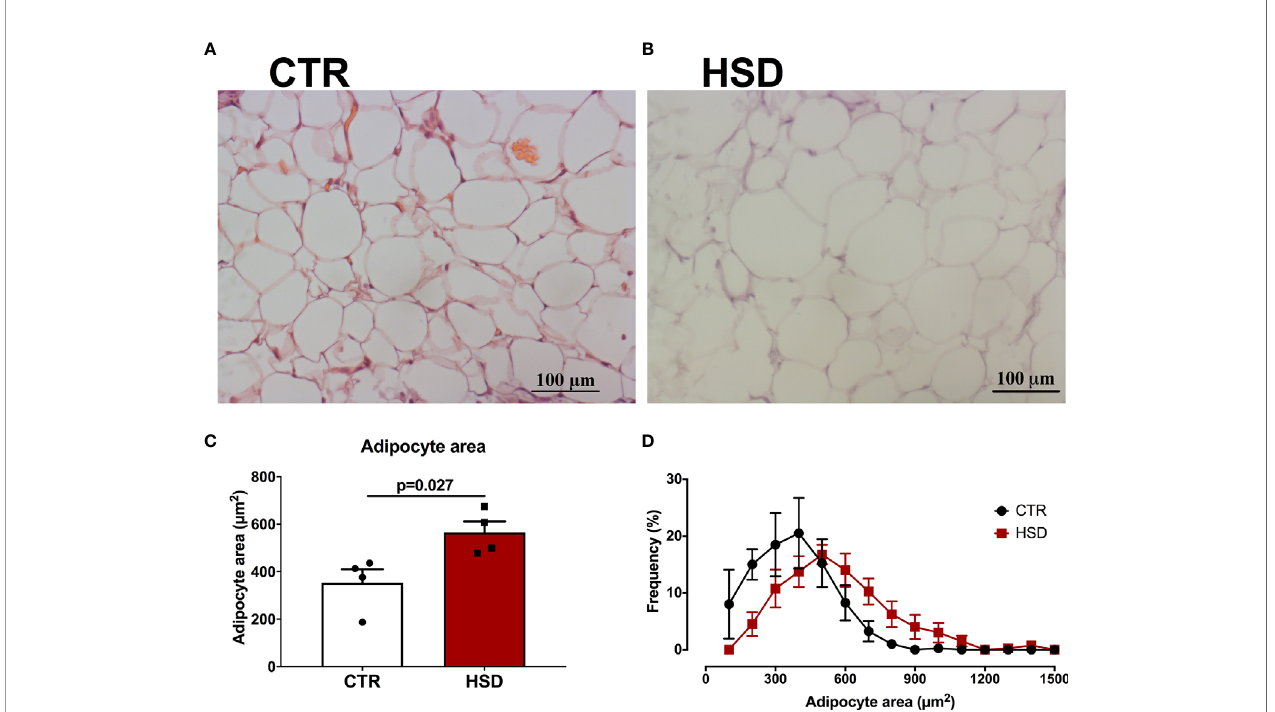
FIGURE 5 | HSD rats present hypertrophy of periovarian adipocytes. Periovarian fat pads were analysed as described in Materials and Methods. (A) Representative micrograph of periovarian fat from a CTR rat. (B) Representative micrograph of periovarian fat from an HSD rat. (C) Mean adipocyte area of periovarian fat. (D) Frequency distribution per adipocyte area. n=4 animals in each group. Graphs express mean ± SEM and bar graphs show individual values. P-values are shown in bar graphs when signi fi cant (p < 0.05) and were calculated using Student t-test in (C)